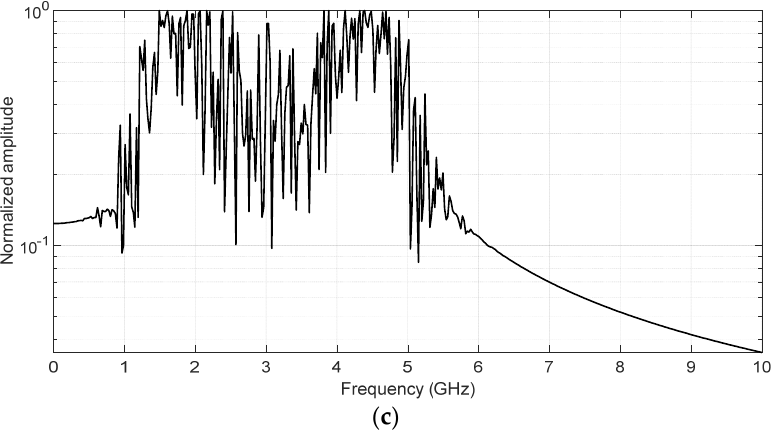
Figure 4. ( a ) The time-domain signal received by the sensor; ( b ) the normalized frequency-domain signal (magnitude) received by the sensor (logarithmic scale); ( c ) the normalized inverted signal (magnitude) received by the sensor in the frequency domain (logarithmic scale). After doing the backward simulation using the FDTD method with the same param- eters as in the forward phase, the distribution of the normalized maximum electric field power over the whole time interval is shown in Figure 5a. In all the figures, the colors represent the intensity of the represented quantity. In that figure, the red circle (o) and black cross (×) show the actual and estimated source locations, respectively. The location of the sensor is shown by the pink square ( □ ) in Figure 5a. An expanded view of the region close to the source location is shown in the figure inset. The localization error for the pro- posed EMIF method is zero. In Figure 5, to estimate the location of the source, the maxi- mum power criterion proposed in [18] is used. The length of the square mask window around the sensor (used to exclude the sensor from the maximum power search domain) is 25 cells along the x - and y -axes.